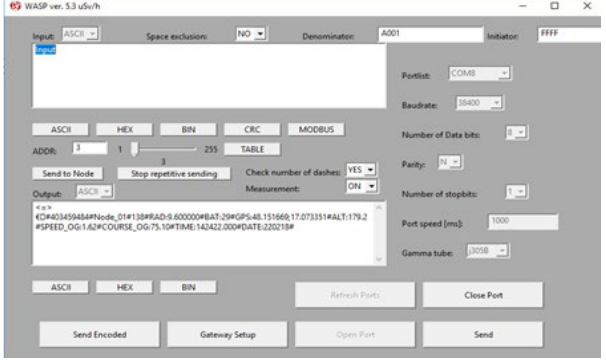
Fig. 2. RMS-WASP control software